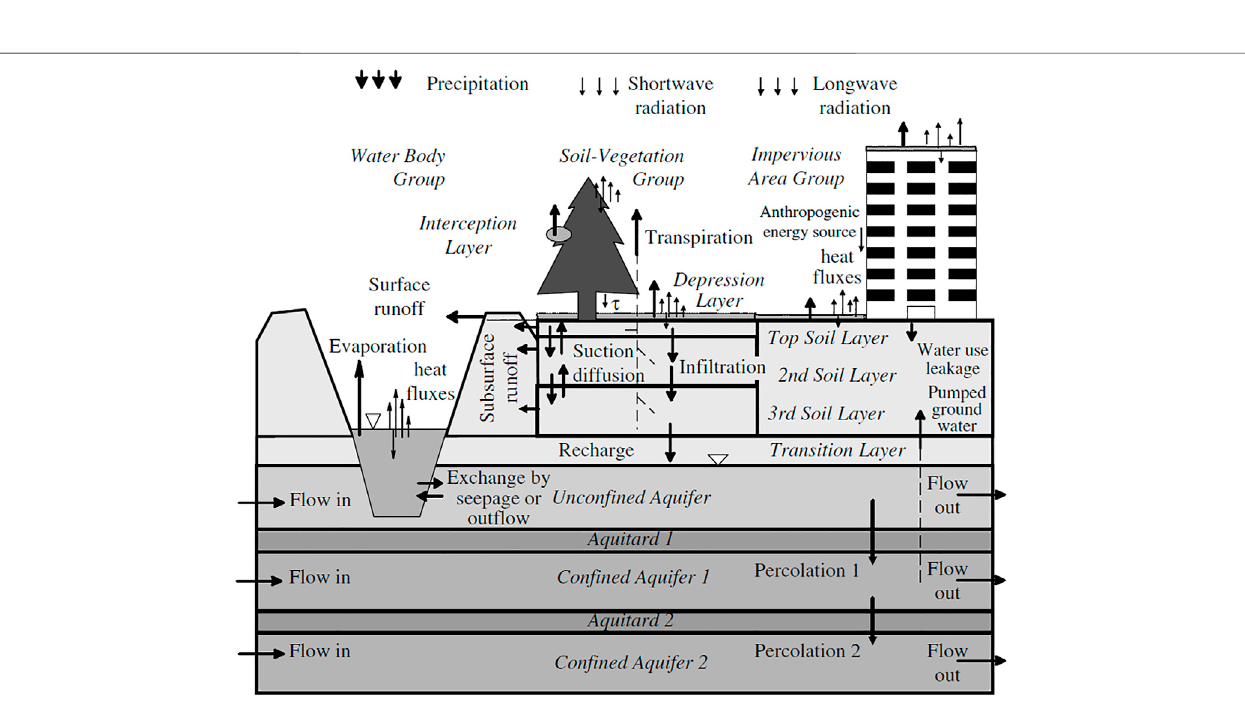
Frontiers in Earth Science |